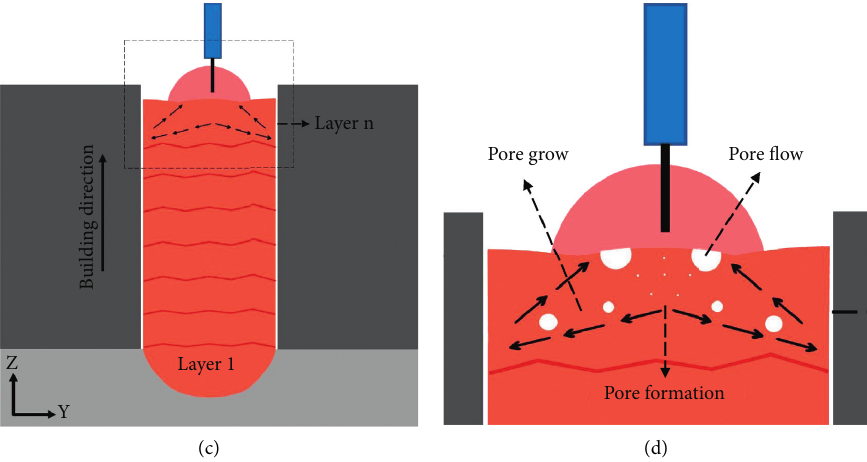
Figure 11: Pore defect generation model of the deposition wall: (a), (b) without the path constraint; (c), (d) with the copper plates constrained path.